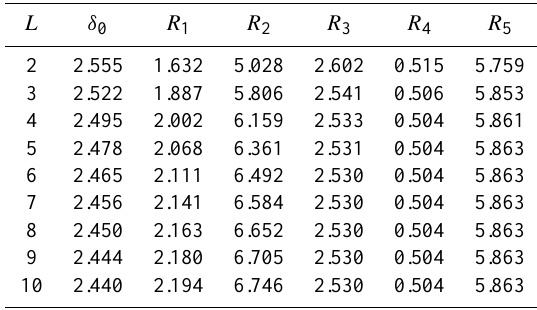
Table 1. Values of